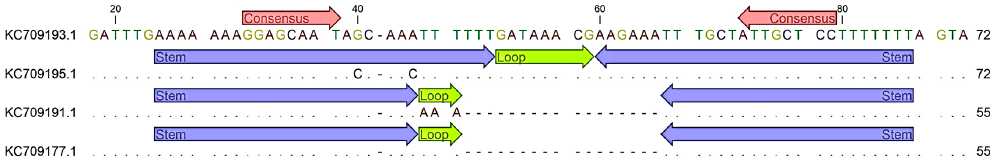
Figure 3. Alignment of selected Hypericum panel psbA 3 ′ UTR sequences. The predicted stem-loop